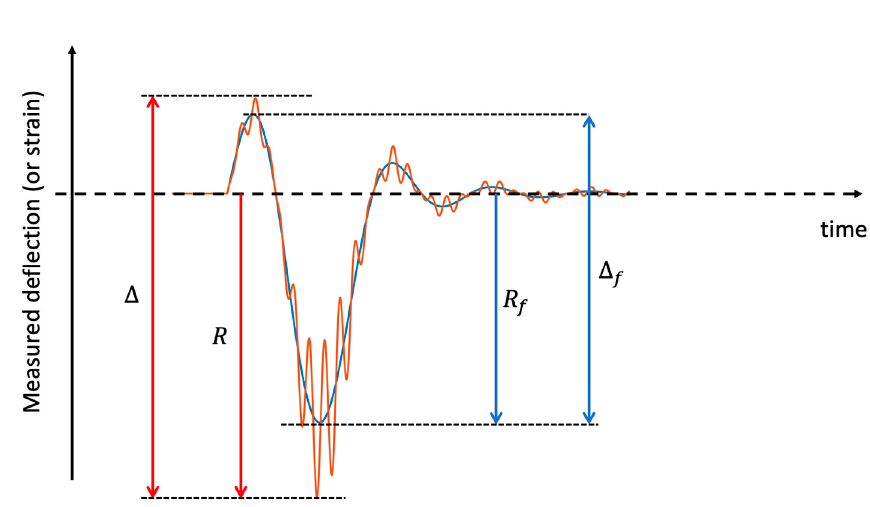
Figure 5. Deflection (or strain) in time of a point of a bridge excited by a dynamic load.